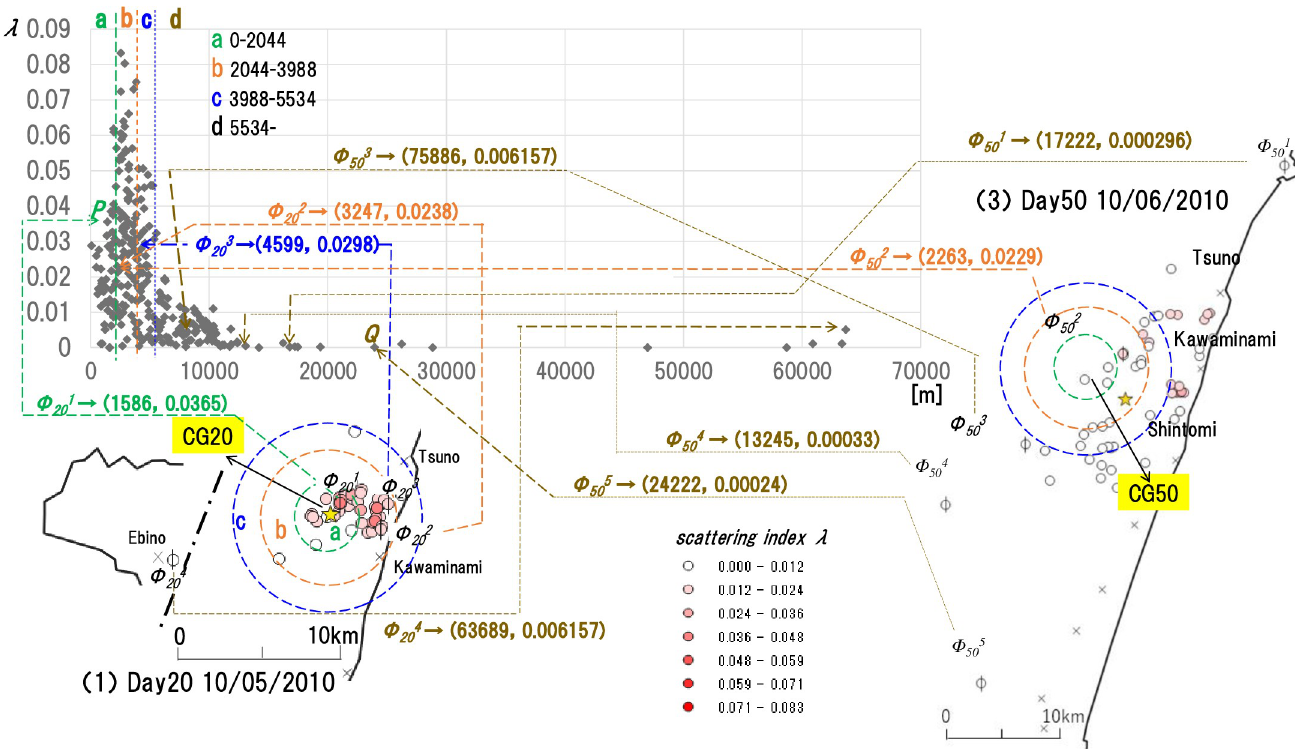
Fig 8. Definition of points that construct the graph in Fig 7. We explain points P and Q with maps (1) and (3) in Fig 5. The radius of the concentric circle a is 2044 m, which is the uppermost limit of the cluster area a. That of b is 3988m, and that of c is 5534m. The boundaries of a and b, b and c, and c and d in Fig 7 are semantically equivalent to the contours of concentric circles a, b, and c. First, we plot point P according to the farm labeled F 201 on map (1), infected on Day 20(10/ 05/2010). 1586m of the coordinates (1586, 0.0365) for point P represents the distance from the center of gravity (CG20) to farm F 201 on this day (Day 20), and 0.0365 represents the scattering index. We plot point Q according to the farmlabeled F 505 on map (3), infected on Day 50(10/06/2010). 24222m of the coordinates (24222, 0.00024) for point Q represents the distance from the center of gravity (CG50) to farm F 505 on this day (Day 50), and 0.0024 represents the scattering index. We figure and plot the others in the same method as of P and Q above. The other points can be defined in the same way as P and Q described